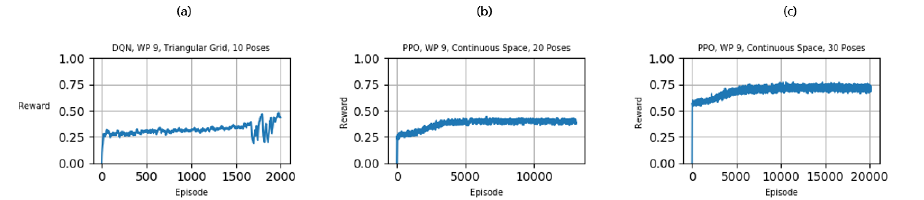
Figure 8. Training results of DQN and PPO aiming at a high coverage ratio. The experiments are publicly available at https://github.com/christianlandgraf/rl_ viewplanning (accessed on 12 March 2021) including training log, the view pose sequences, and trained models. Additionally, we provide a video illustrating the inspection setup including the robot kinematics and the 3D sensor as well as the accelerated training setup without robot kinematics. The video is available at https://www.youtube.com/watch?v= 0mqPu0_qdD4 (accessed on 12 March